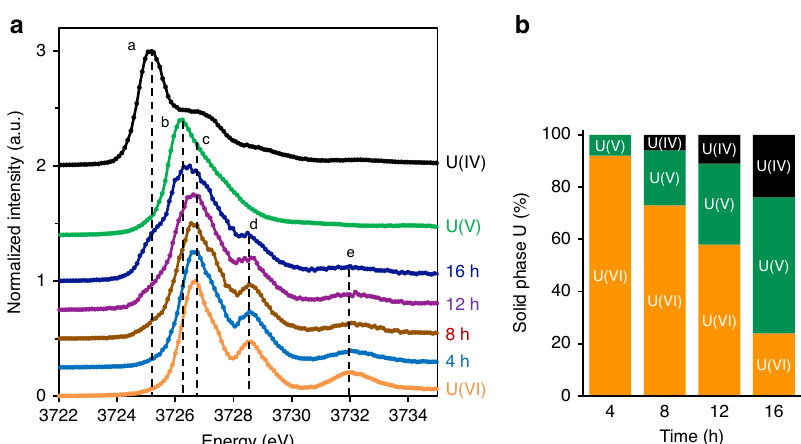
Fig. 1 X-ray absorption spectroscopy of U-magnetite solid phase. a M 4 edge high-energy-resolution fl uorescence detection X-ray absorption near-edge structure spectroscopy (M 4 edge HERFD-XANES) spectra for U(VI) reacted with magnetite after 4, 8, 12, and 16 h, comparing to U(IV) (UO 2 ), U(V) (uranate in UMoO 5 ), and U(VI) (uranyl(VI)-nitrate) reference spectra. Dashed lines in a – c indicate the white line energy positions for U(IV), U(V), and U (VI) valence states, respectively; d and e indicate post-edge shoulders for the uranyl(VI) structure. b The fractions of U(IV), U(V), and U(VI) components in each U-magnetite solid sample as a function of time as calculated with the iterative transformation factor analysis (ITFA) method. Source data are provided as a Source Data fi